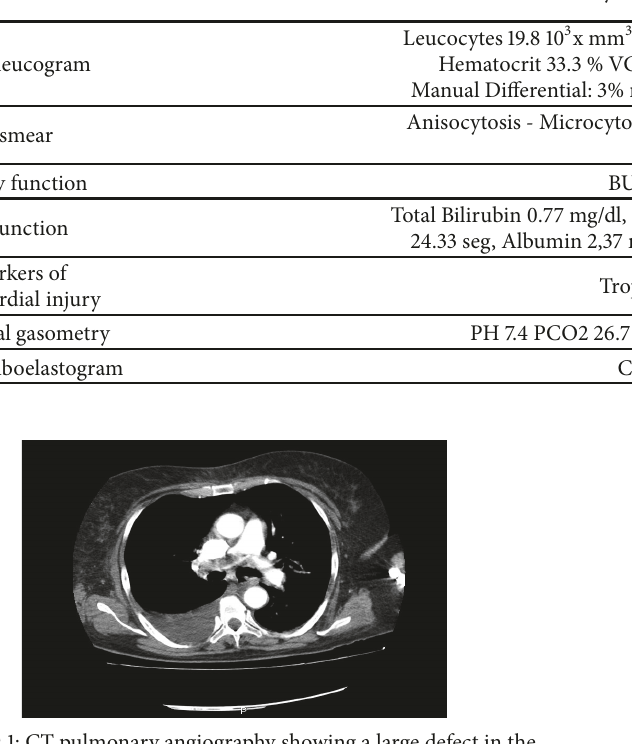
Table 1: Laboratory results.